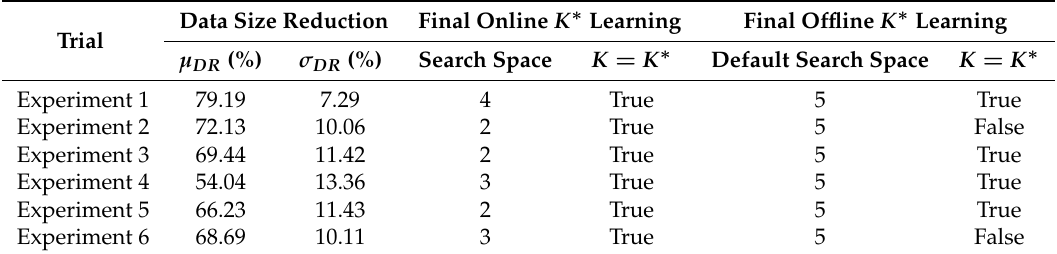
Table 2. Efficiency comparison between the online and offline KmP gas discrimination